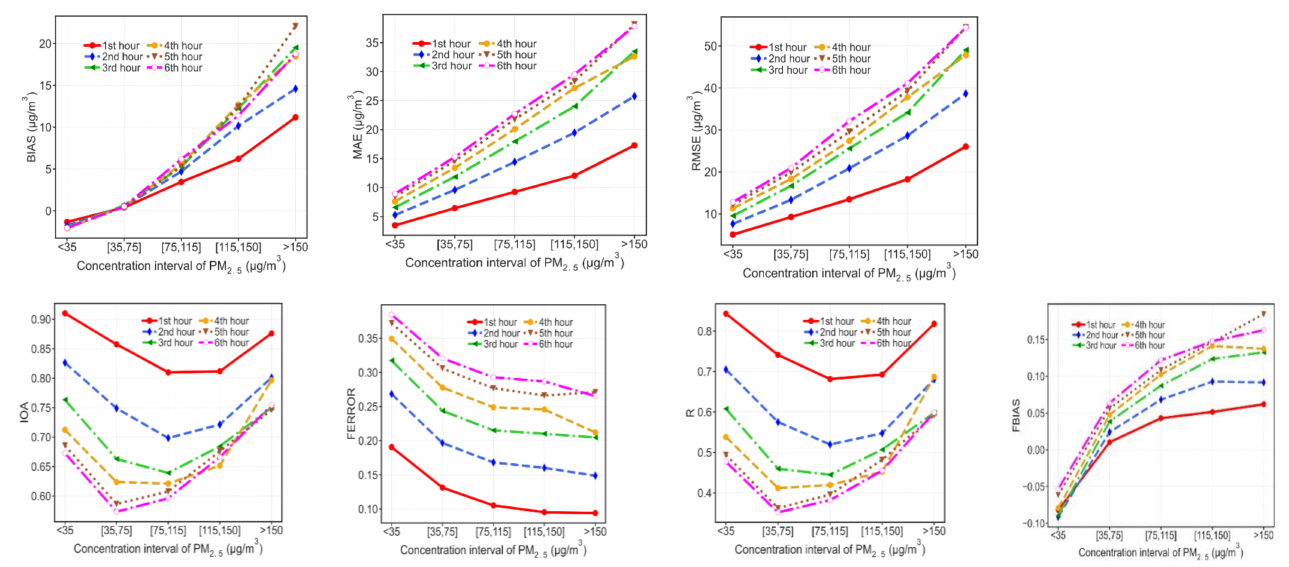
Figure 8. Forecast performance of the OR-ELM-AR model under different pollution levels.